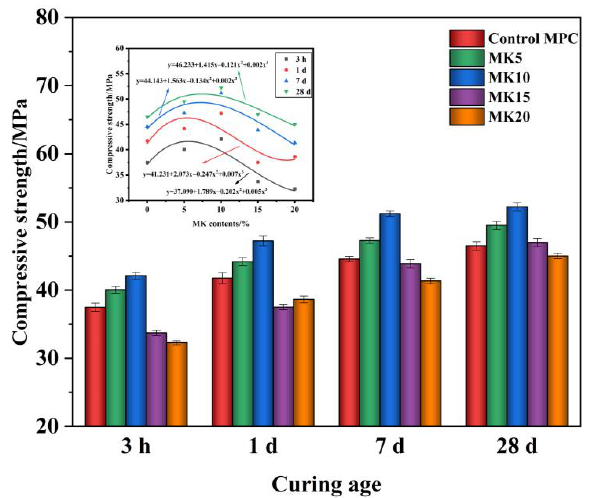
Figure 15. The effect of MK content on MPC compressive strength.